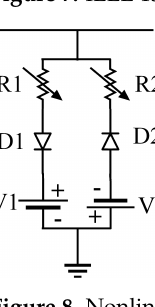
Figure 8. Nonlinear HIF model utilized for time-domain simulation